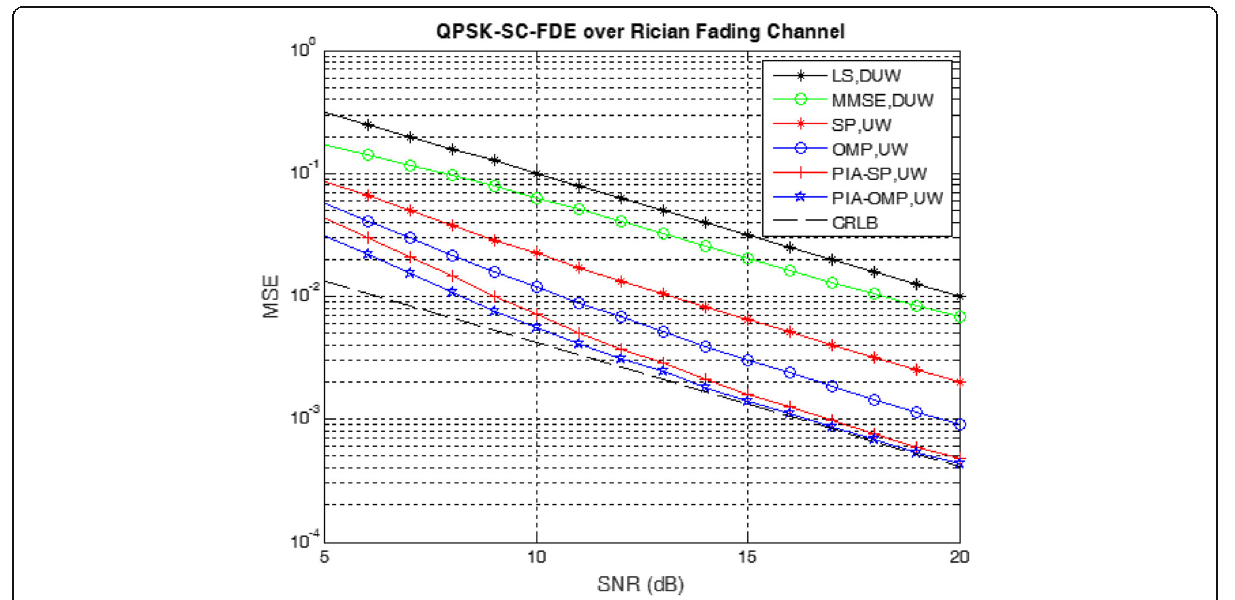
Fig. 4 The MSE performance comparison between the proposed channel estimation scheme and its conventional counterparts with P = 64